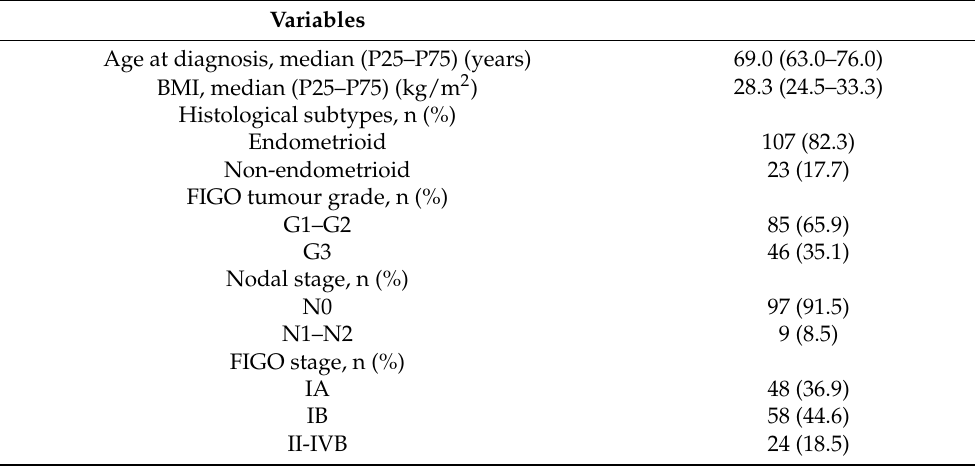
Table 1. Clinicopathological characteristics of EC patients ( n = 132).